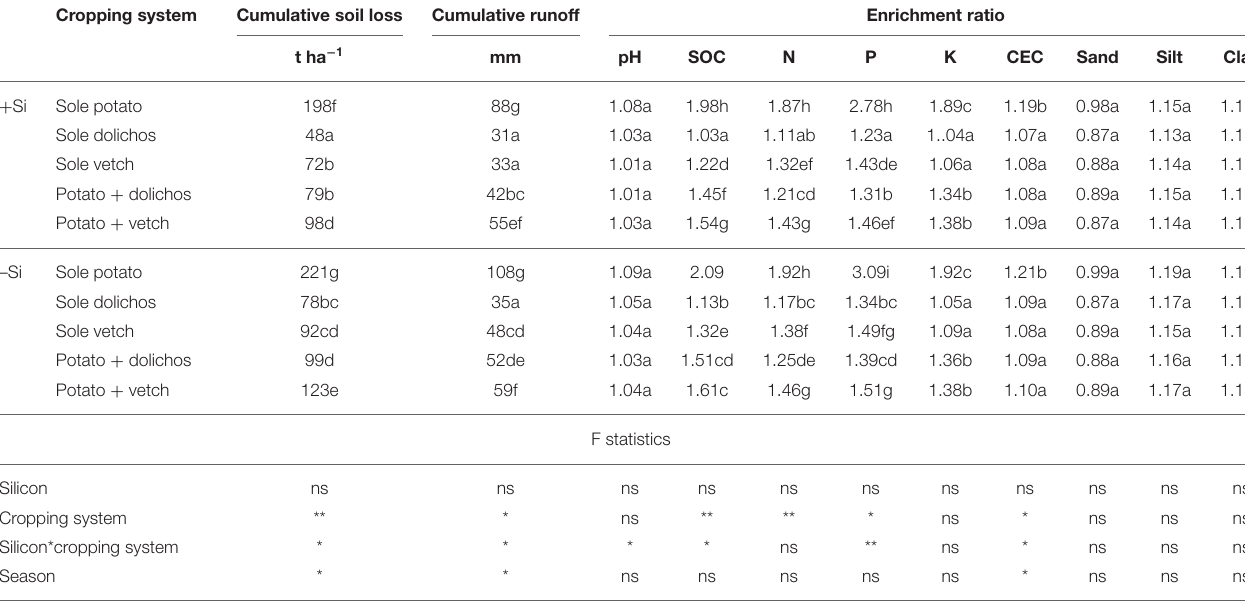
TABLE 5 | Intercropping and silicon effects on soil erosion and soil nutrient